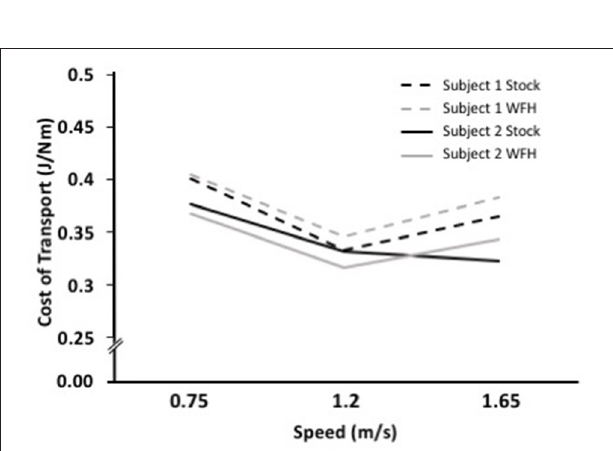
FIGURE 4 | WFH (gray) and BiOM stock (black) controllers produce similar metabolic cost of transport during level walking at variable speed. Cost of transport (J/Nm) for two subjects at three walking speeds (0.75, 1.2, and 1.65 m/s). Broken lines = Subject 1; solid lines = Subject